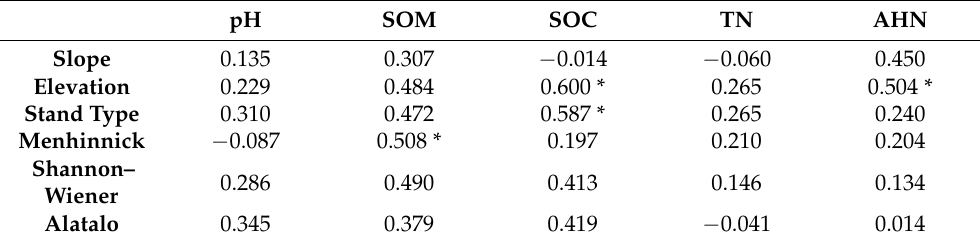
Table 4. Correlation analysis of soil nutrients, topographic factors, and preparation factors.